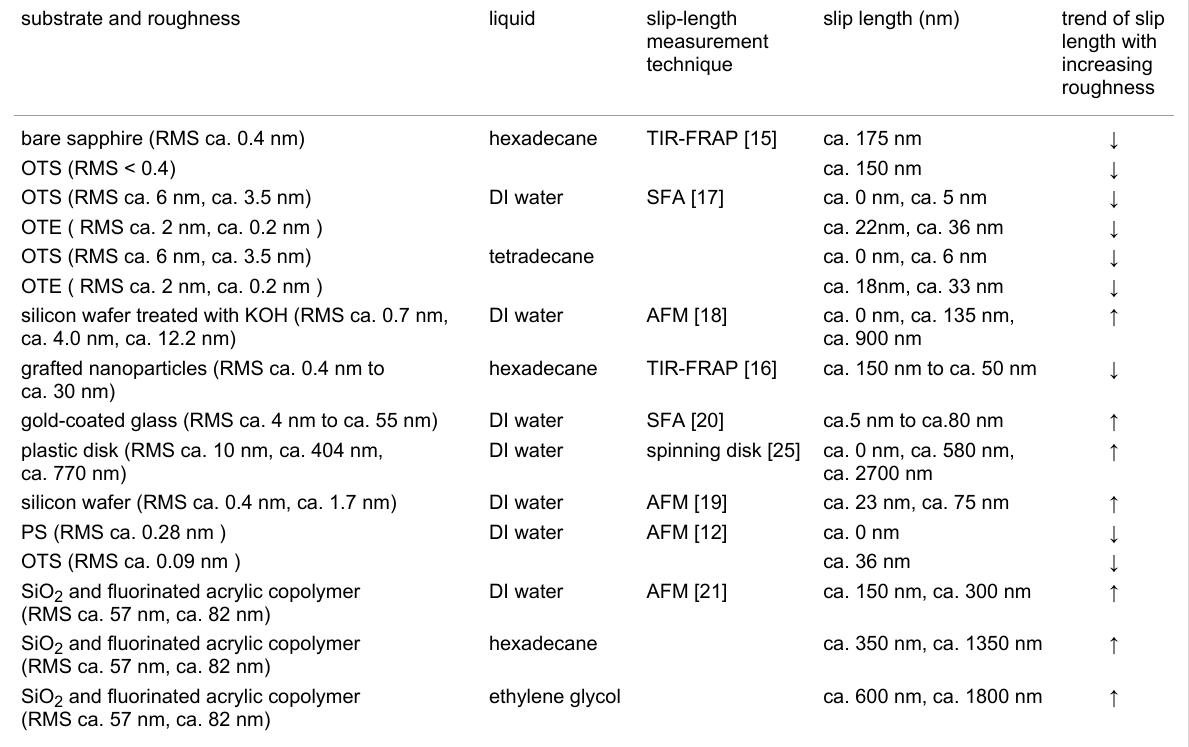
Table 1: Summary of experimental studies on the effect of roughness on slip